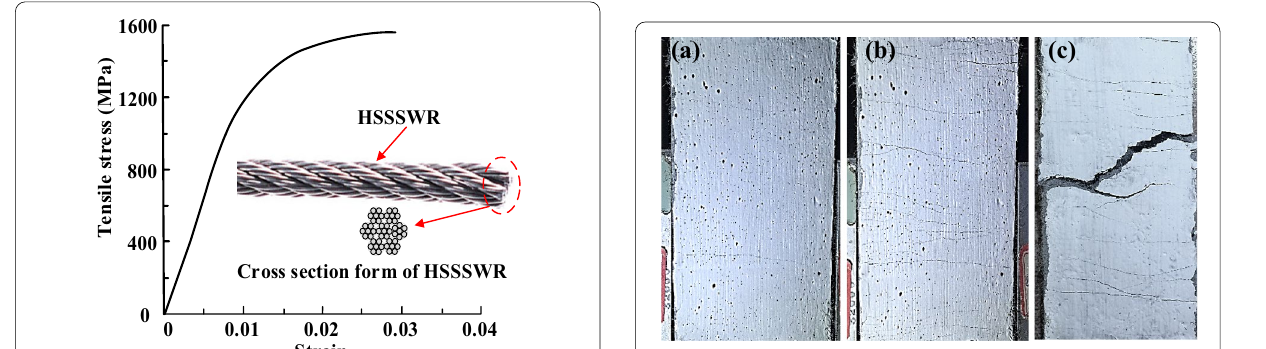
Fig. 5 Crack patterns of the specimen in group B1: a at cracking load; b at the saturation state and c at